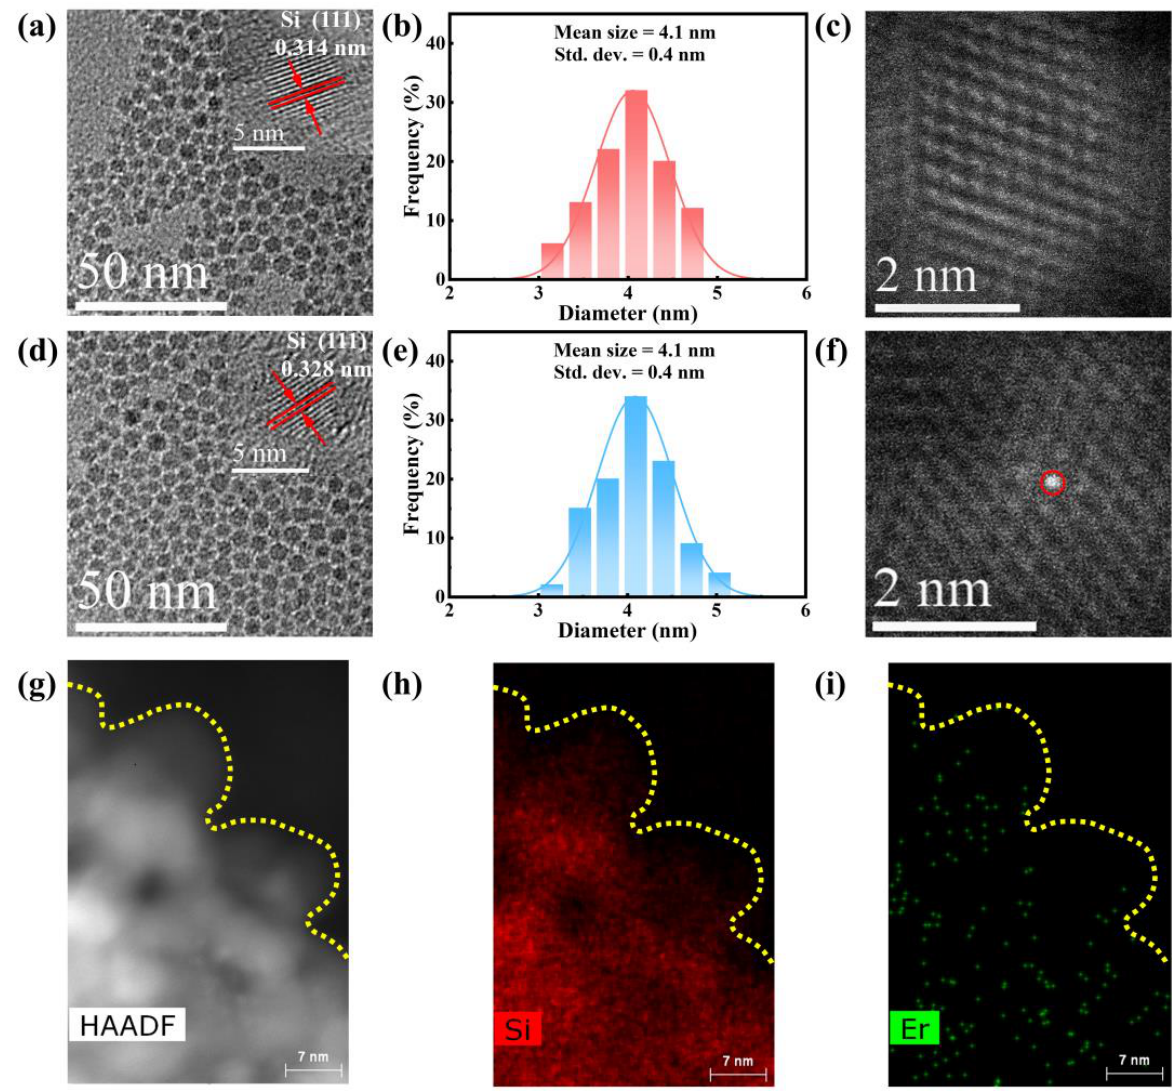
Figure 2. TEM images, size distribution, and HAADF-STEM images of ( a – c ) undoped and ( d – f ) Er-hyperdoped Si QDs. ( g ) HAADF-STEM image of Er-hyperdoped Si QDs and corresponding element maps for ( h ) Si and ( i ) Er.